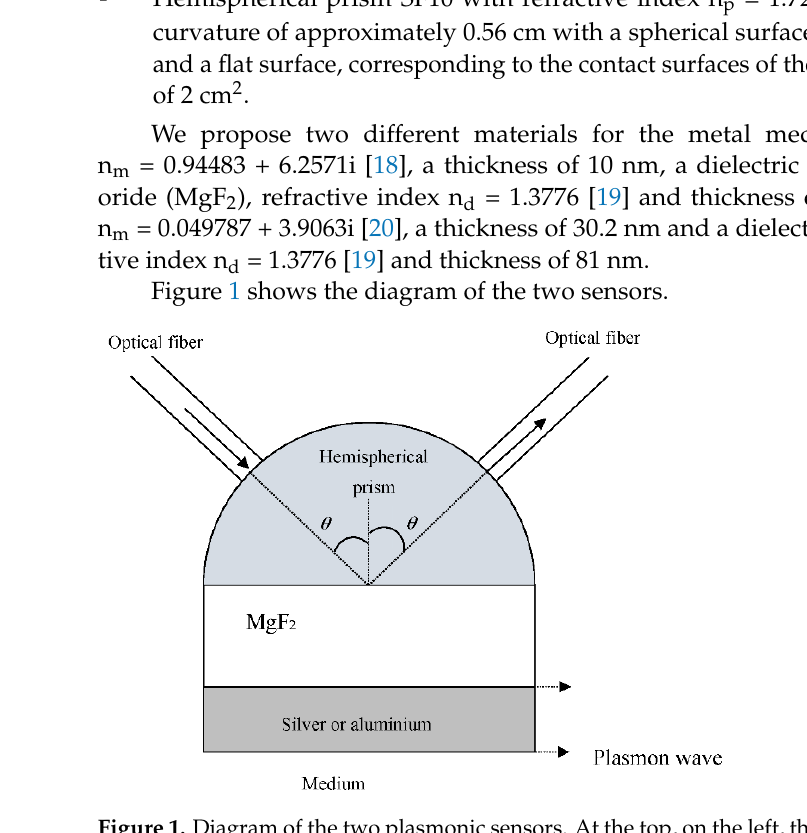
Figure 1. Diagram of the two plasmonic sensors. At the top, on the left, the optical fiber transports the incident radiation to the hemispherical prism, and at the top, on the right, another optical fiber collects the reflected radiation. The SPPs are also shown propagating through the MgF 2 -silver/aluminum and/or silver/aluminum-medium interfaces.